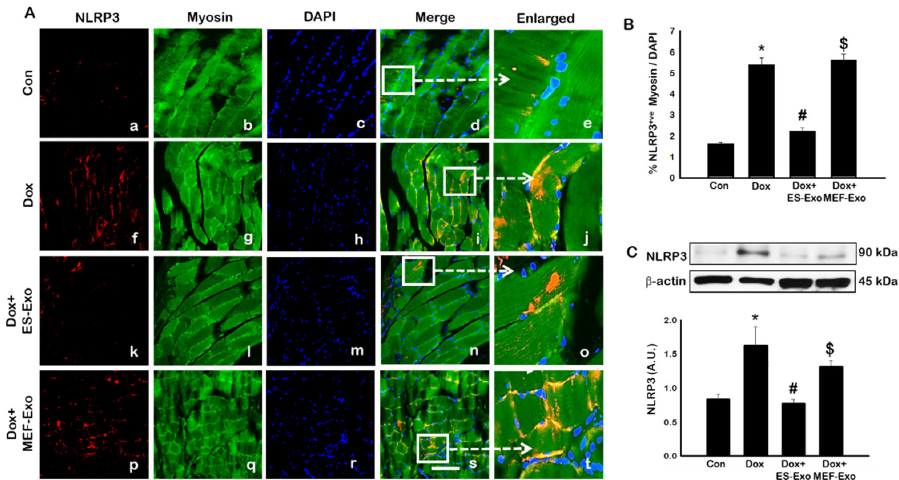
Figure 3. ES-Exos treatment of mice inhibits NLRP3 inflammasome formation in the soleus muscle after Dox administration. ( A ) Representative photomicrographs of soleus muscle sections stained with myosin and inflammasome marker NLRP3. Each box shows NLRP3 + cells in red ( a , f , k , p ), myocytes in green ( b , g , l , q ), DAPI in blue ( c , h , m , r ), merged images ( d , i , n , s ), and enlarged areas of merged images ( e , j , o , t ). ( B ) Histograms from quantitative analysis of NLRP3 + cells over total DAPI. ( C ) Representative blot and densitometric analysis of NLRP3. Error bars = mean ± S.E.M. * p < 0.05 vs. control, # p < 0.05 vs. Dox, $ p = non-significant vs. Dox, one-way ANOVA followed by Tukey test; western blot quantities are represented as A.U. Scale bar = 100 µm, n = 14–16, male and female ( B ) and n = 6–8, male and female ( C ). Images taken at 40 × magnification.